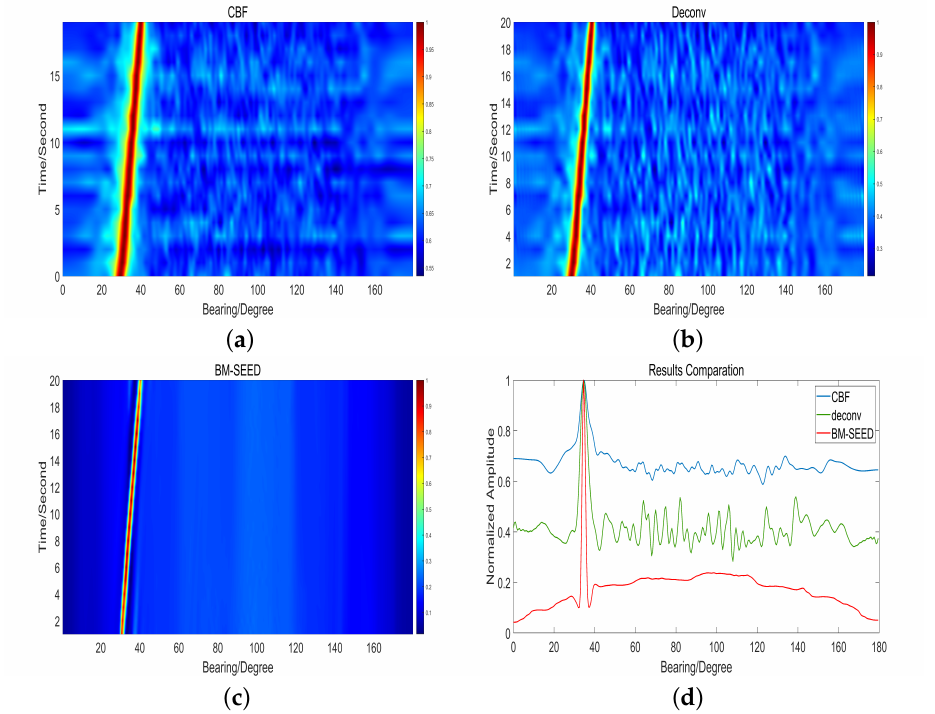
Figure 6. Experiment Results under − 20 dB SNR. ( a ) CBF result under − 20 dB SNR; ( b ) Deconv result